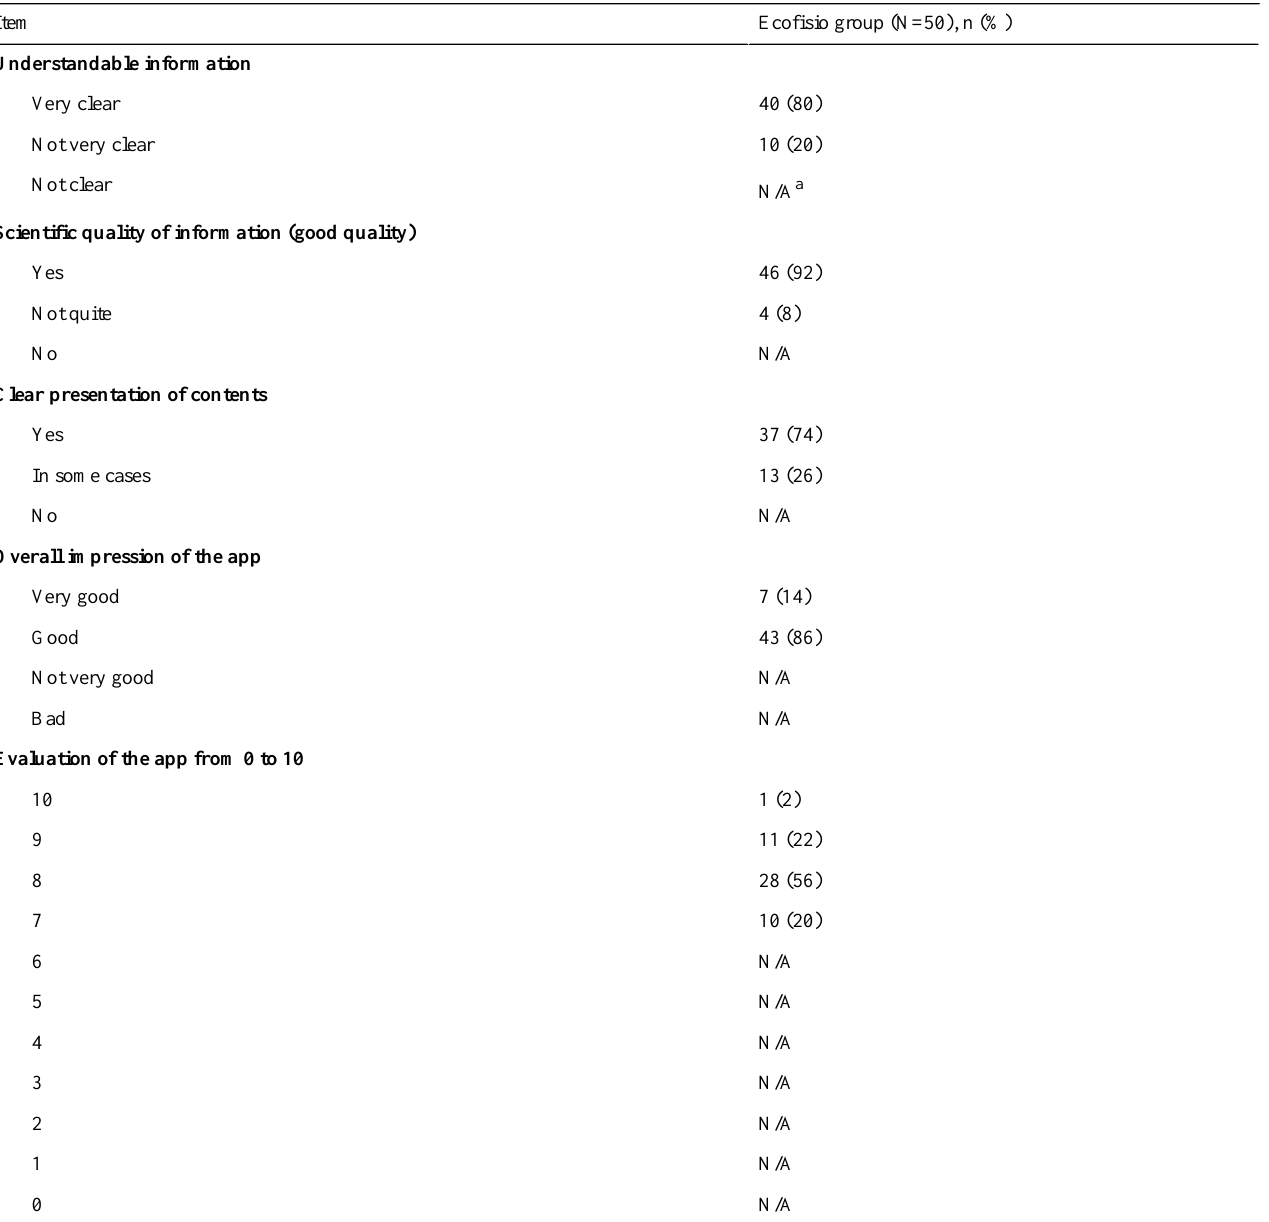
Table 4. Descriptive data related to the Ecofisio group’s